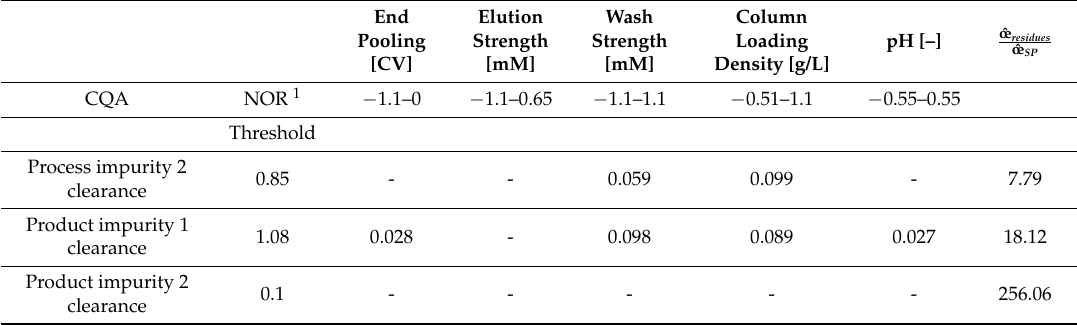
Table 1. p -values of significant process parameters that were used in the statistical models for each critical quality attributes (CQA) of CC 1. Normal operating ranges and thresholds are given for each process parameter or critical quality attribute, respectively. Non-significant parameters are indicated with “-”. Also, the ratio of standard deviation of raw residuals of the model by the standard deviation at set-point ( ˆ σ residues is given for each ˆ σ SP